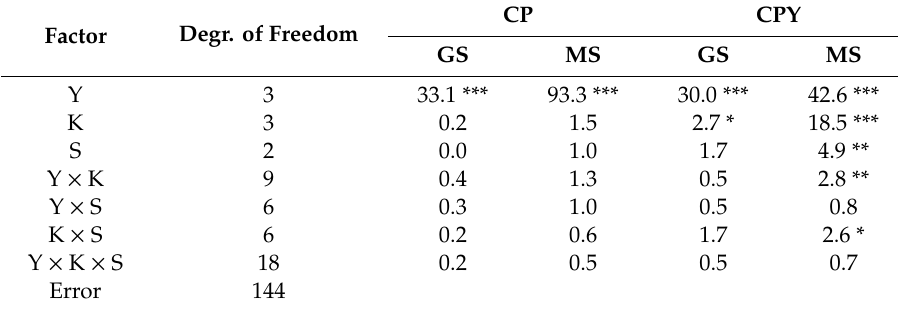
Table 2. Three-way ANOVA results (F values): e ff ect of year (Y), potassium (K), sulfur (S) application, and interaction between factors on crude protein content (CP) and crude protein yield (CPY) depending on seed maturity. GS, immature seeds; MS, mature seeds. CP CPY Factor Degr. of Freedom GS MS GS MS Y 3 33.1 *** 93.3 *** 30.0 *** 42.6 *** K 3 0.2 1.5 2.7 * 18.5 *** 0.0 Y × K 9 0.4 1.3 0.5 2.8 ** Y × S 6 0.3 1.0 0.5 0.8 K × S 6 0.2 0.6 1.7 2.6 * Y × K × S 18